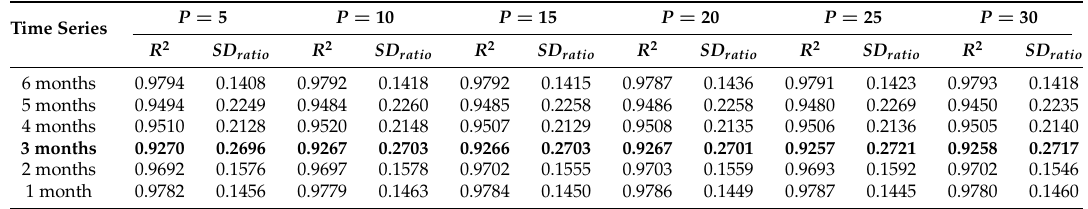
Table 8. Performance Index for time horizon prediction with the worst performance highlighted.